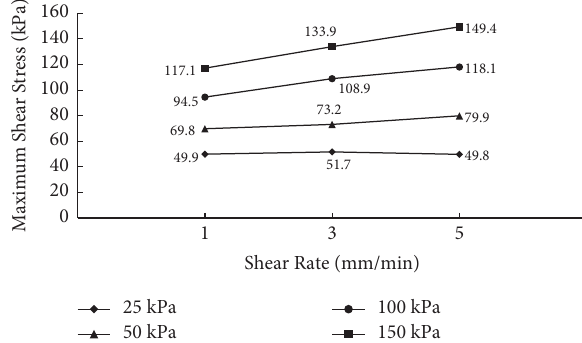
Figure 13: Variation curve of the maximum shear stress under diferent shear rates.